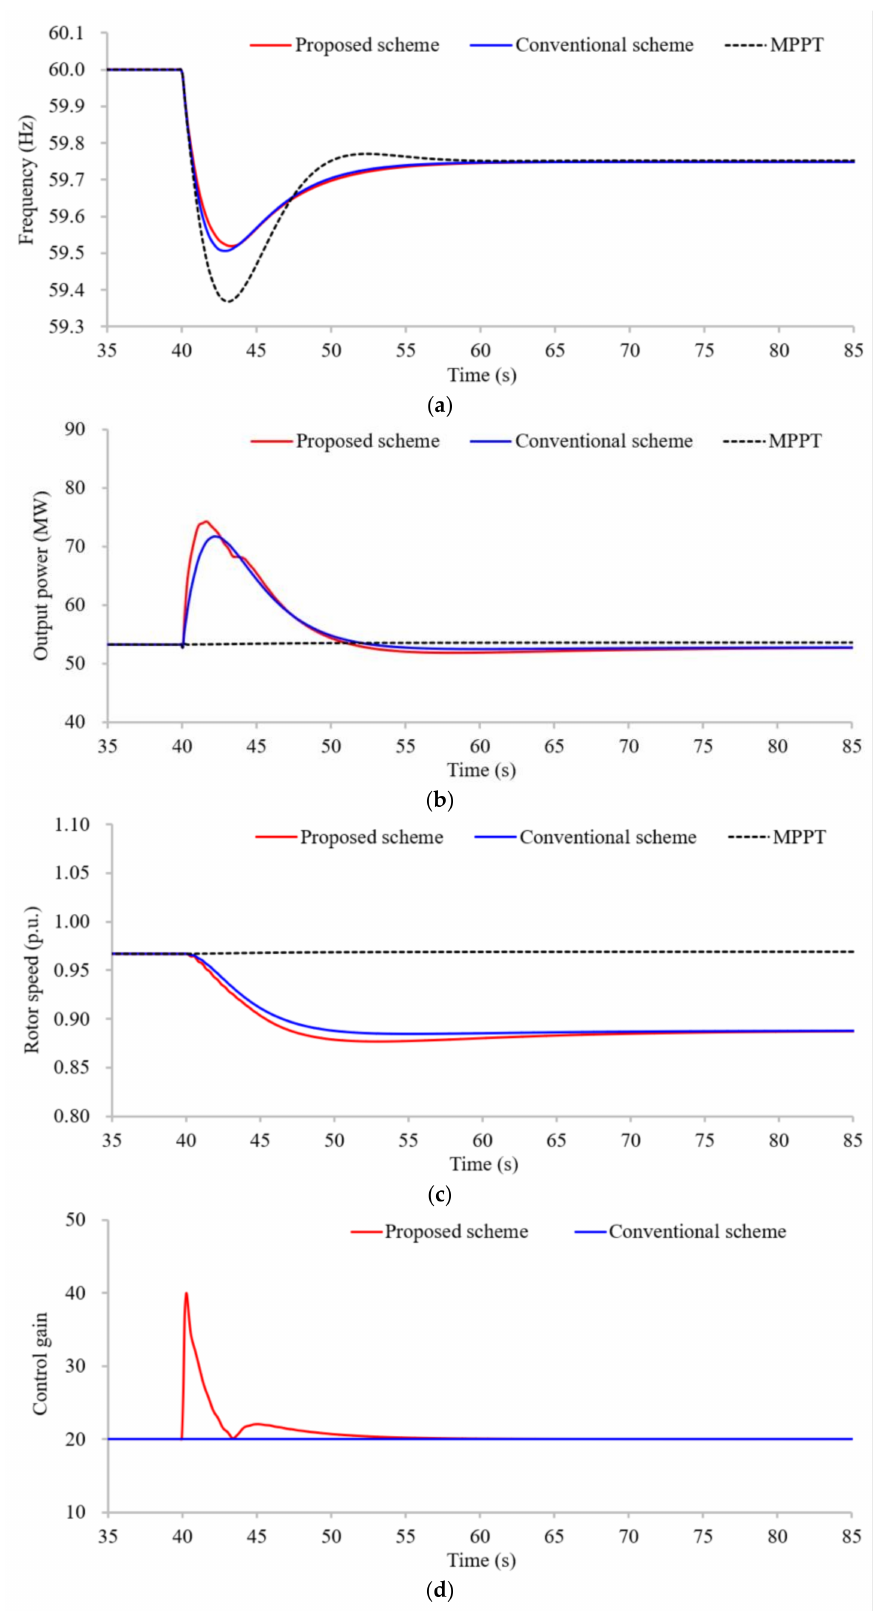
Figure 8. Simulation results for Case 3: ( a ) System frequencies; ( b ) Active power of the DFIG; ( c ) Rotor speeds; ( d ) Control